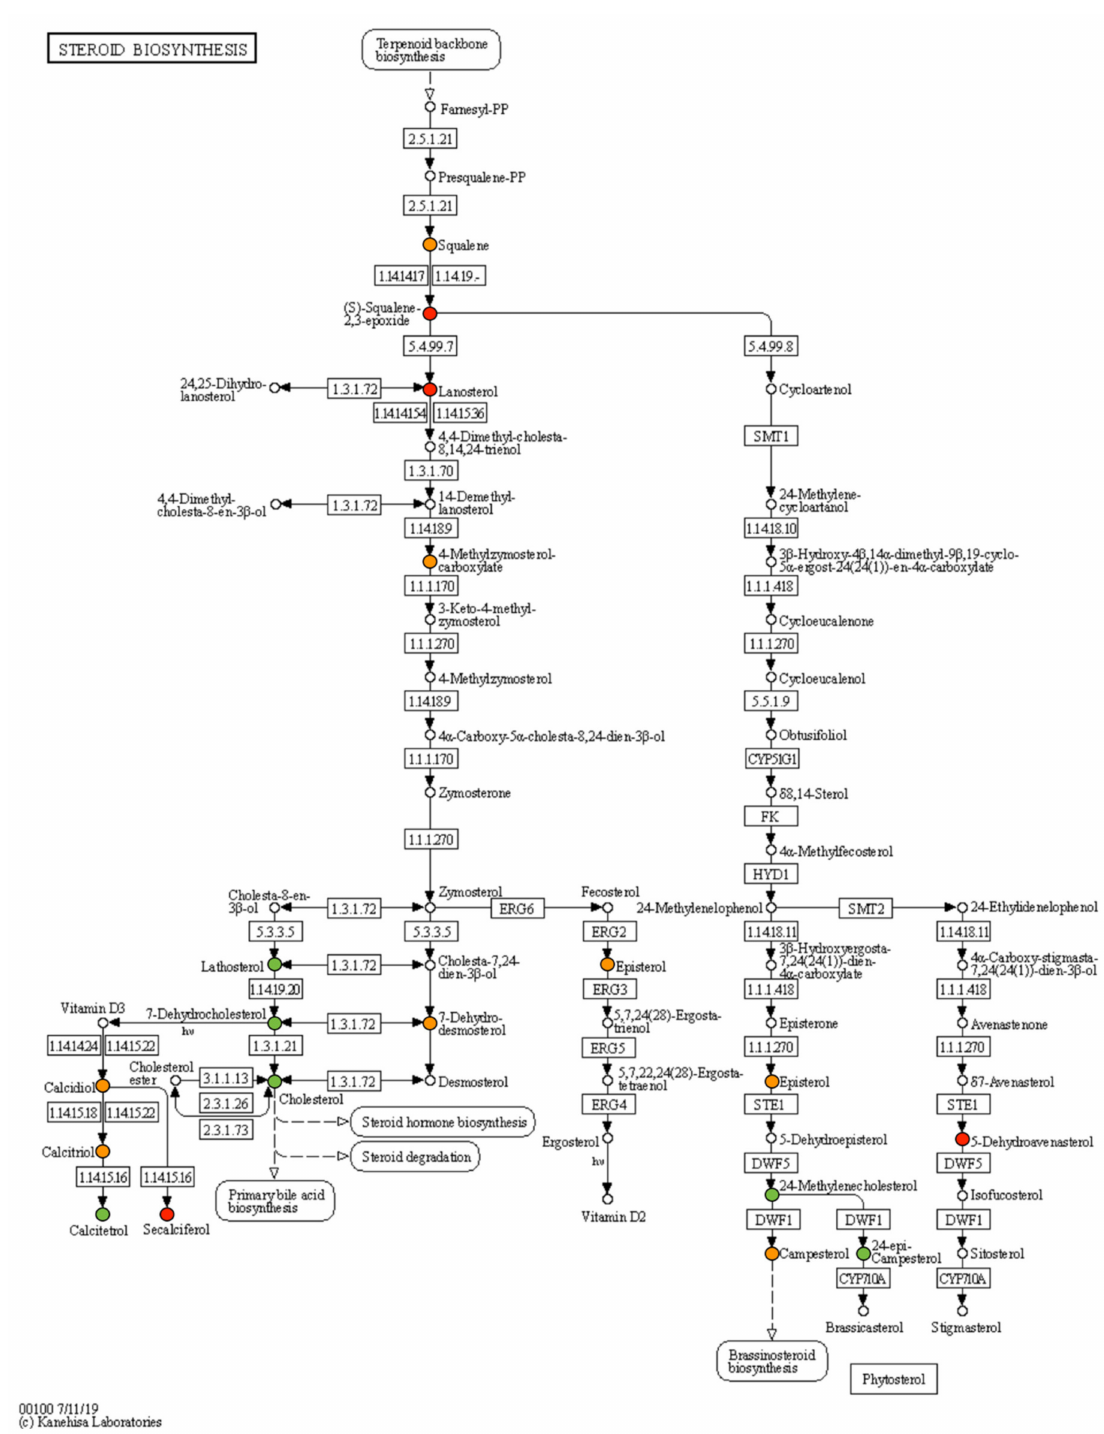
Figure 6. Proposed steroid biosynthesis pathways in Homo sapiens (human). Di ff erent colour points were targeted / identified metabolites in prepuberal o ff spring born after the embryo manipulation during the transfer procedure or vitrified embryos procedure compared to nonmanipulated. Green means downaccumulated metabolite ( p ≤ 0.05), red means upaccumulated metabolite ( p ≤ 0.05) and orange means no significant di ff